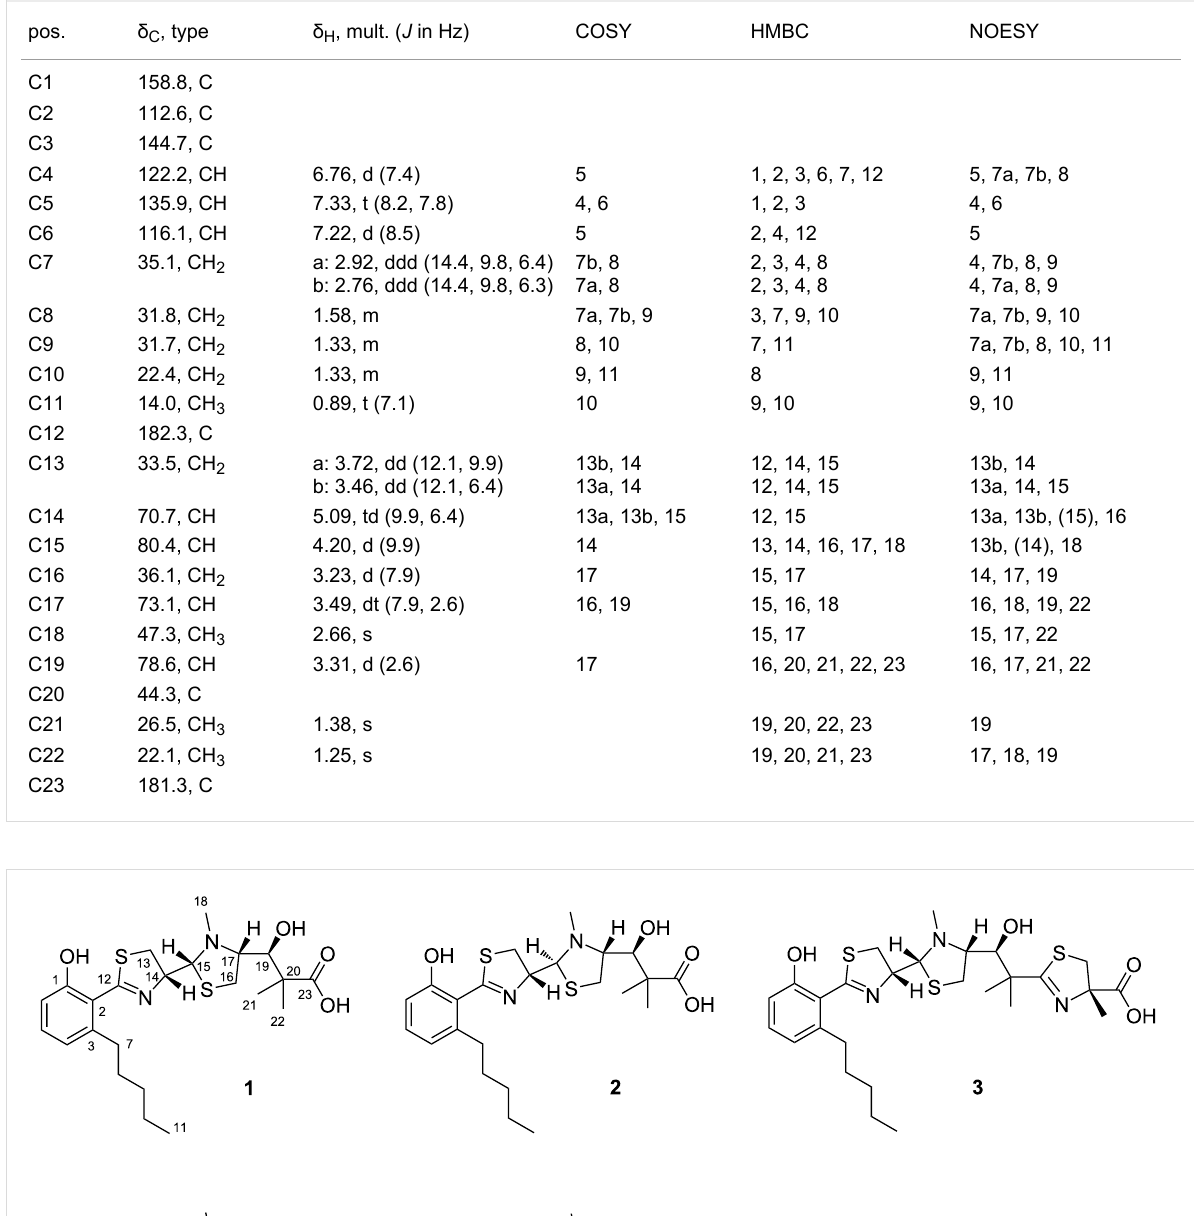
Table 1: NMR spectroscopic data of 1 in CDCl 3 .